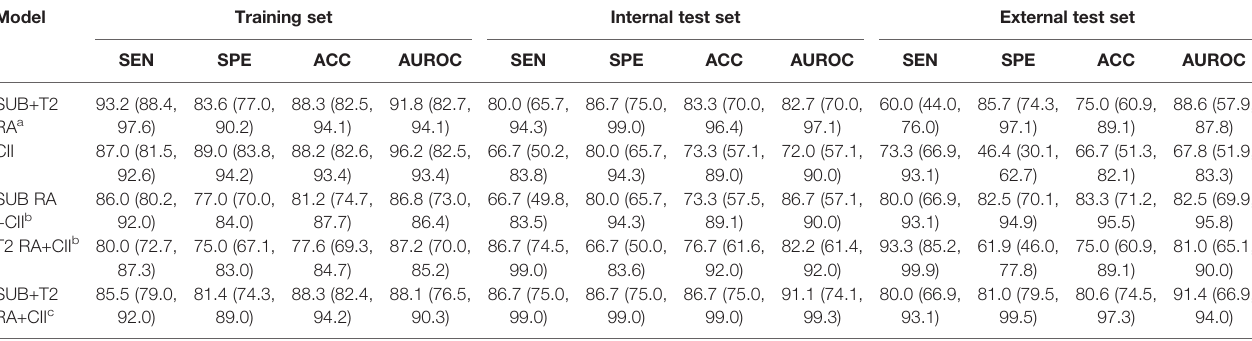
TABLE 4 | Comparison of the performances between RA, CII, and RA+CII fusion models for the classi fi cation of malignant vs . benign MR-detected additional lesion. Model